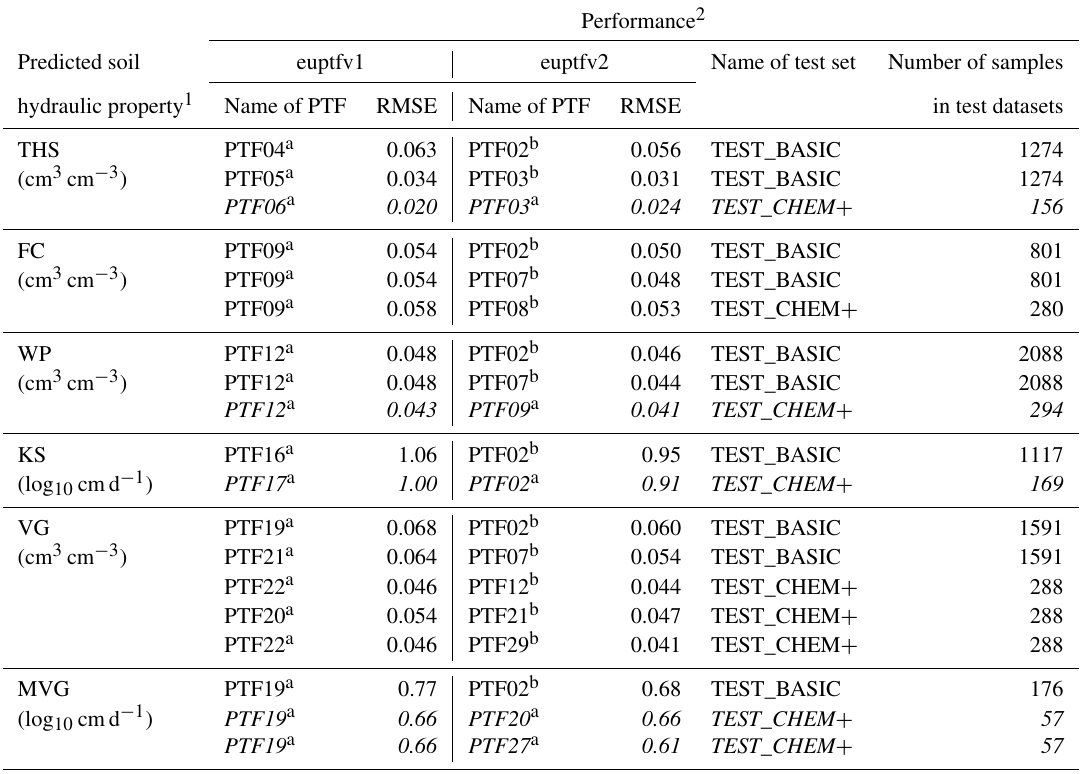
Table 10. The results of comparing the performance of euptfv1 and euptfv2 on the test sets of EU-HYDI to predict soil hydraulic properties. Rows in italic indicate cases where there was no significant difference between the two